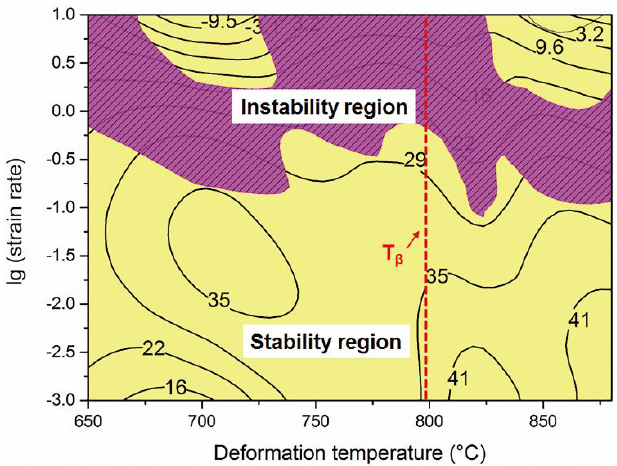
Figure 3. Processing map of TB18 alloy at a true strain of 0.9.